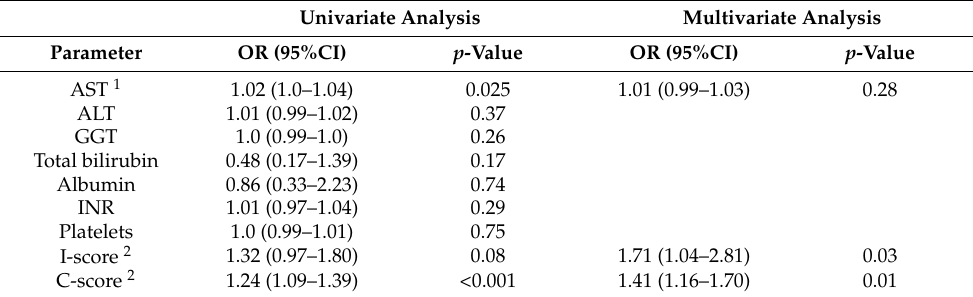
Table 6. Predictive factors for NASH, as assessed using univariate and multivariate regression models.